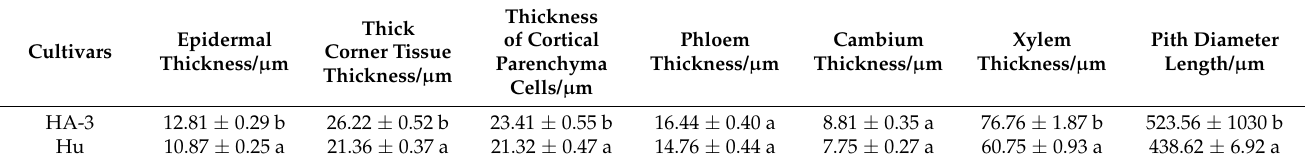
Values in the table represent the mean ± SE. Different lower-case letters (a and b) indicate significant differences between the HA-3 and Hu groups at the level of p < 0.05, respectively (Student’s t -test). Table 2. Comparison of epidermis and mesophyll structures between HA-3 and Hu.